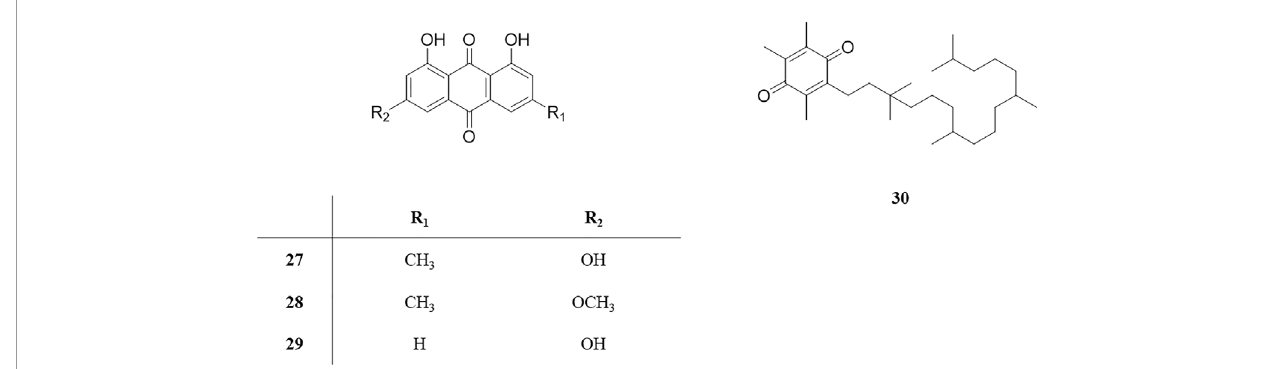
FIGURE 3 | Structure of anthraquinones from P. perfoliatum.